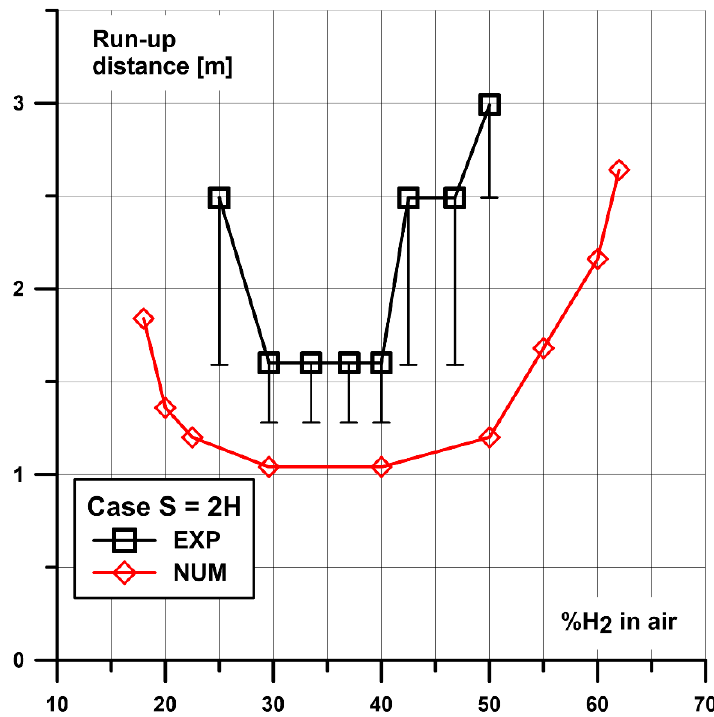
Figure 13. Run-up distances for S = 2H spacing geometry. Experimental data whiskers cover the distance range of possible transition to detonation placement.